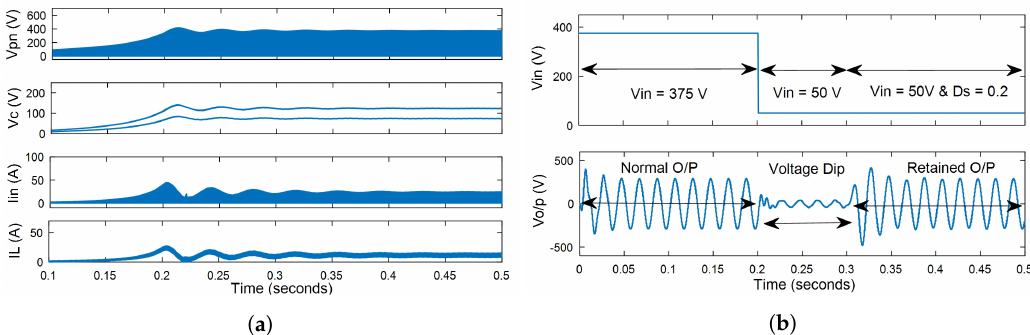
Figure 14. Simulation results: ( a ) soft-start waveform in case 3, and ( b ) dynamic voltage compensation in case